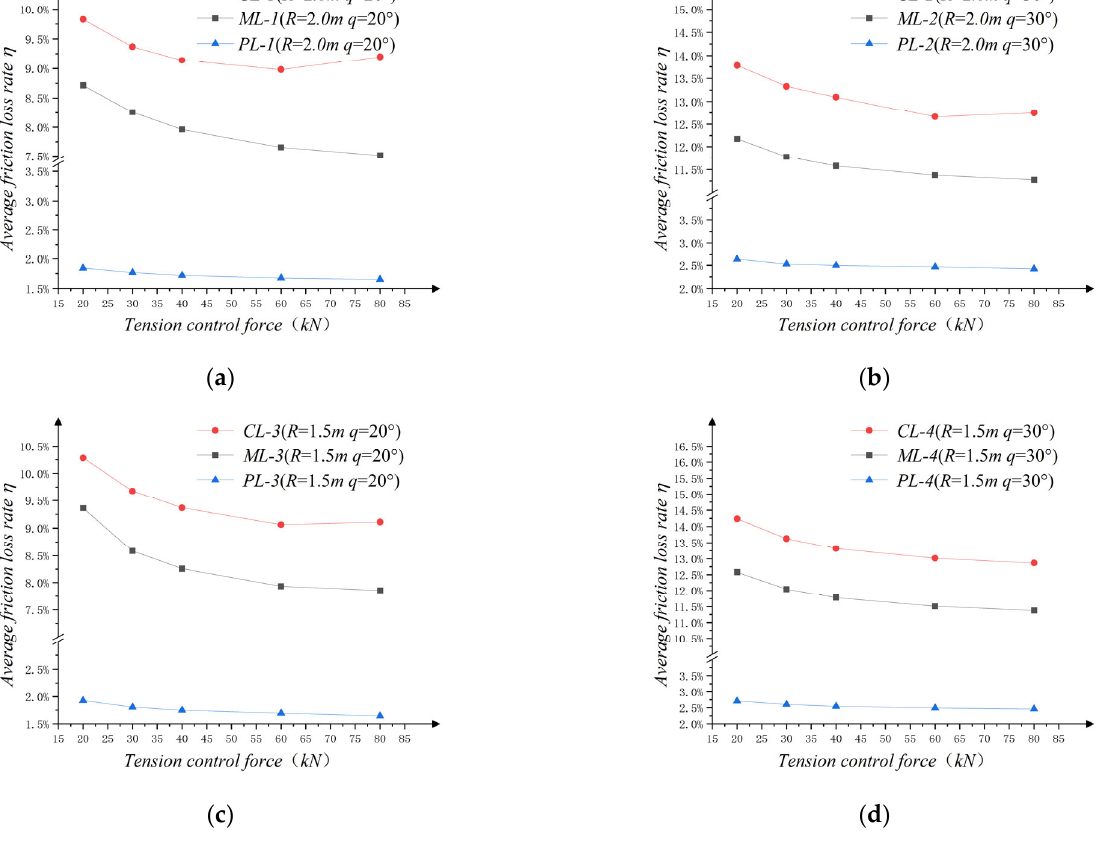
Figure 9. Comparison of data with different friction coefficients μ only: ( a ) comparison group of CL ‐ 1, ML ‐ 1, and PL ‐ 1; ( b ) comparison group of CL ‐ 2, ML ‐ 2, and PL ‐ 2; ( c ) comparison group of CL ‐ 3, ML ‐ 3, and PL ‐ 3; ( d ) comparison group of CL ‐ 4, ML ‐ 4, and PL ‐ 4.